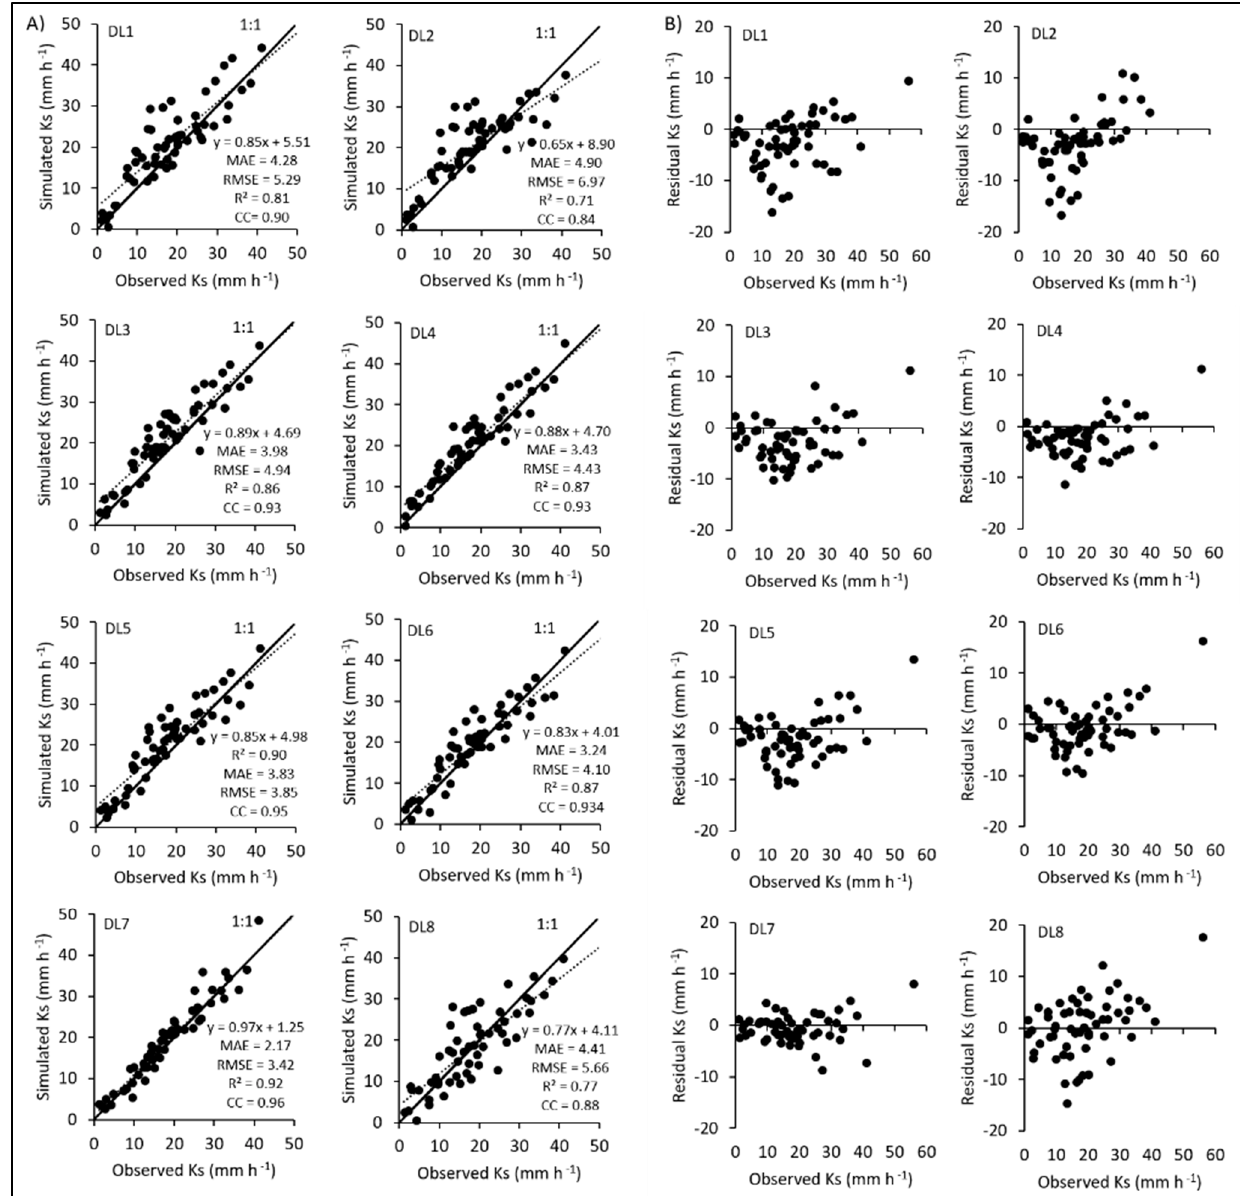
Figure 6. Scatter and residual plots of the DL model with eight combinations of soil input data.